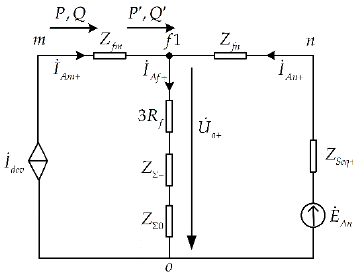
Figure 13. Simplified compound sequence network under a phase-A-to-ground fault at f1.